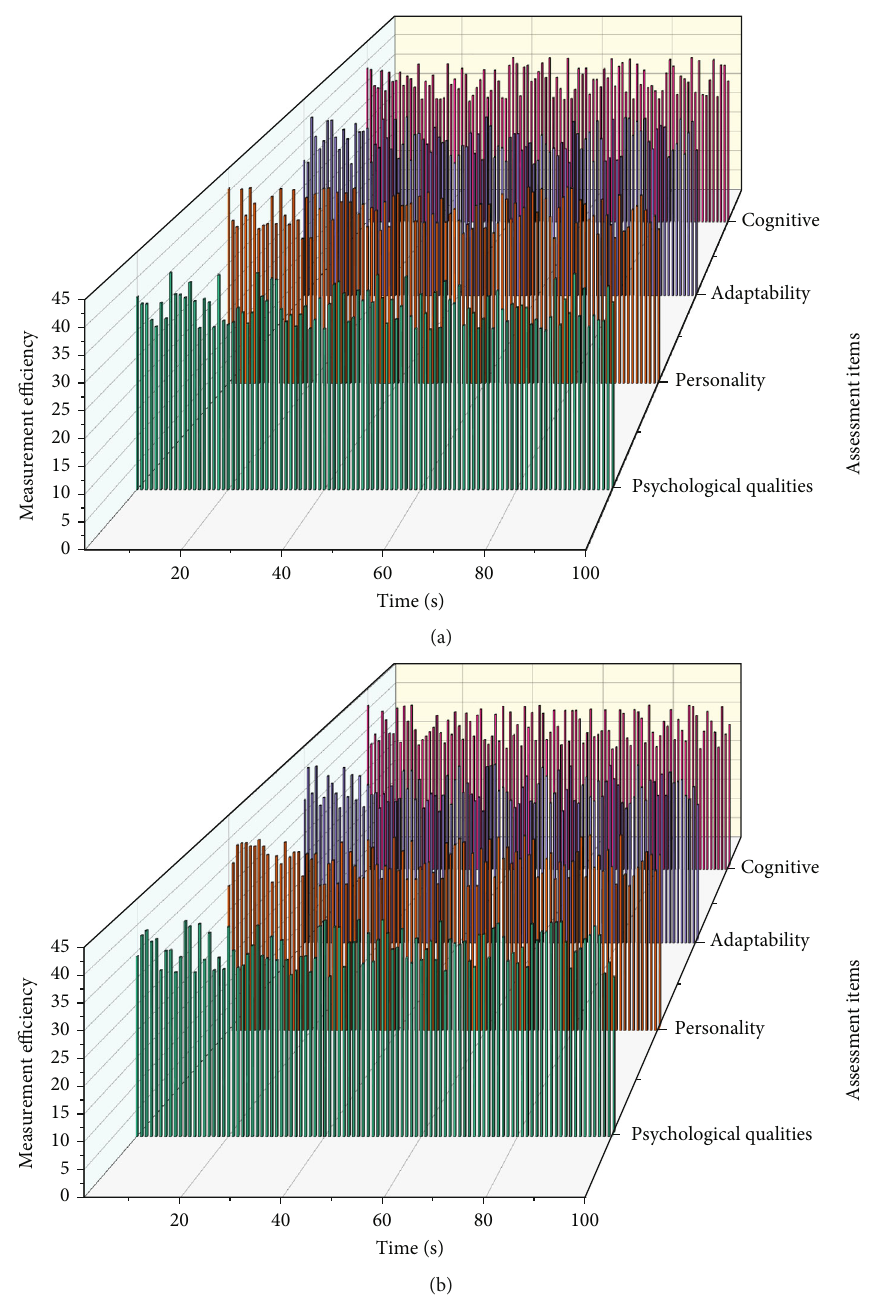
Figure 4: Comparison results of measuring management e ffi